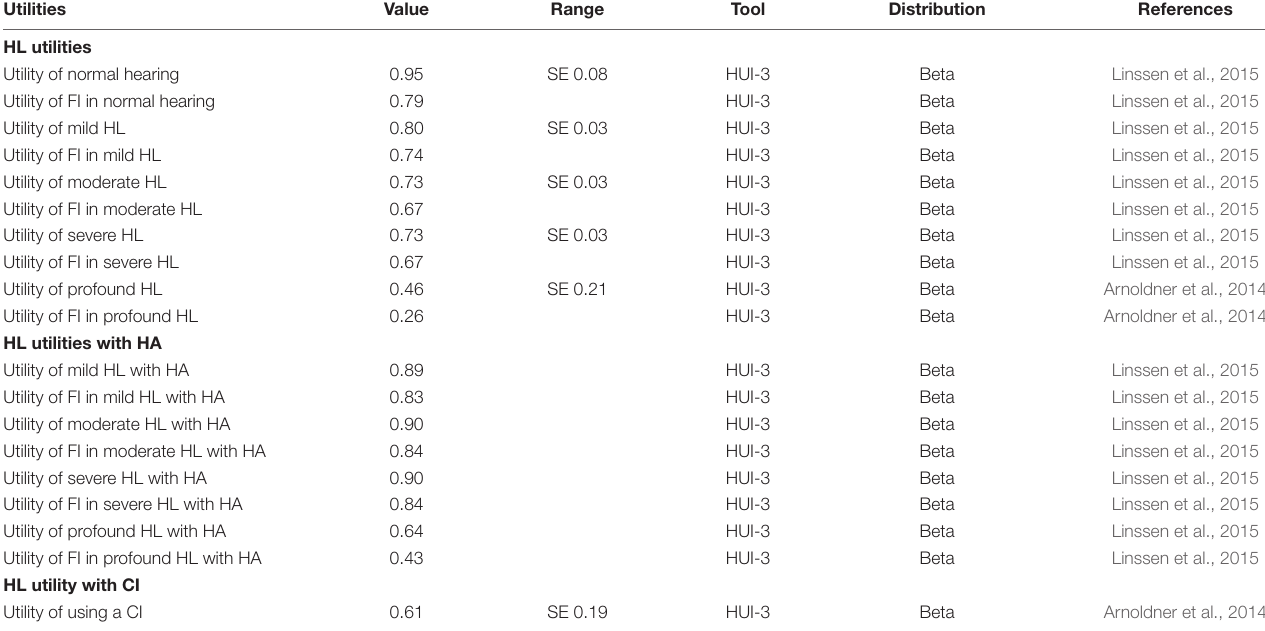
TABLE 2 | Utilities.